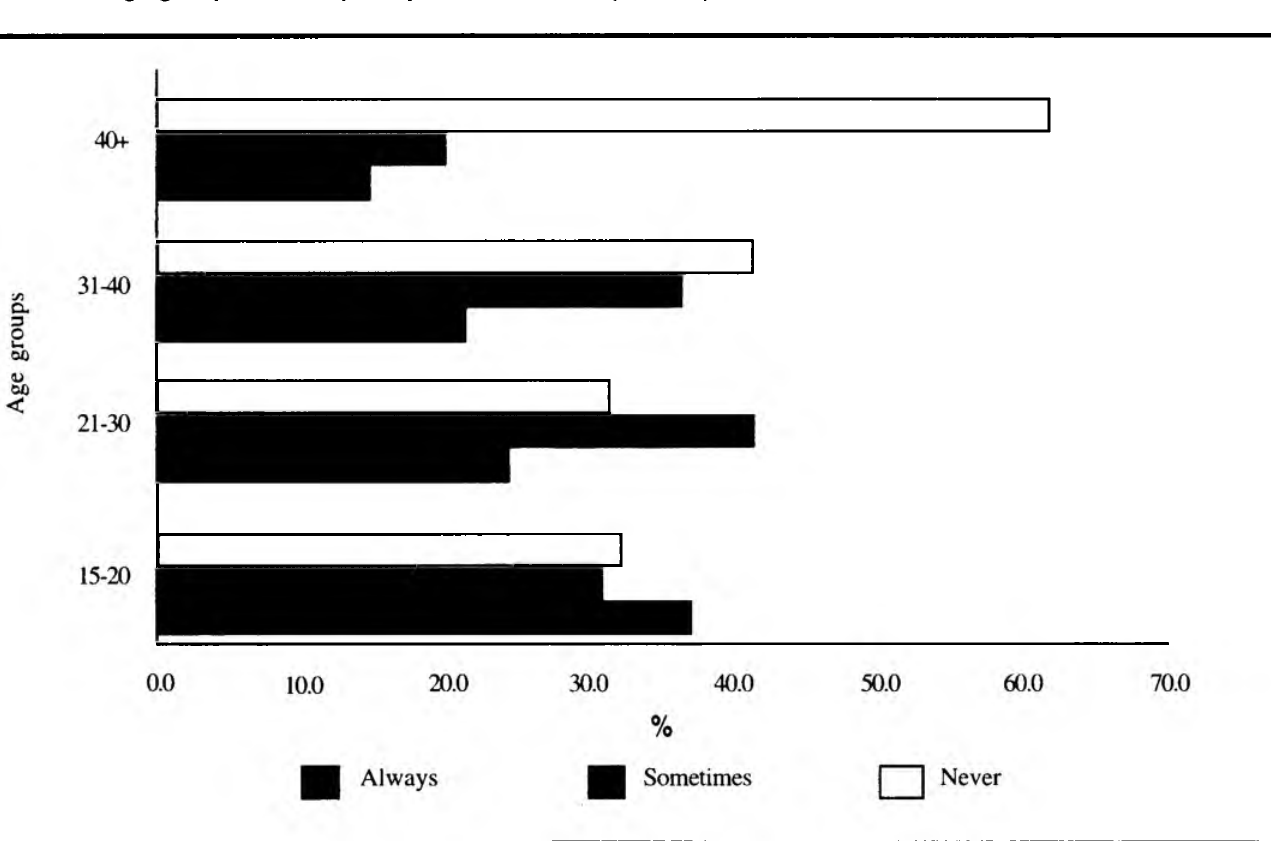
FIGURE 6: Age groups and frequency of condom use